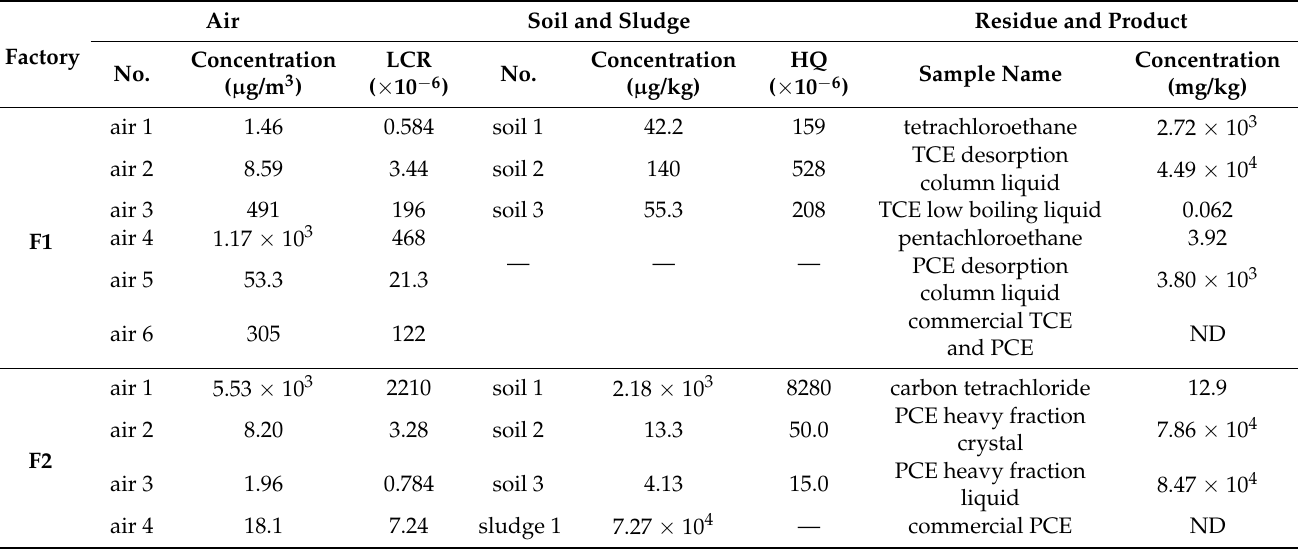
Table 1. Concentrations of HCBD in air, soil, sludge, residue, and product samples from F1 and F2.